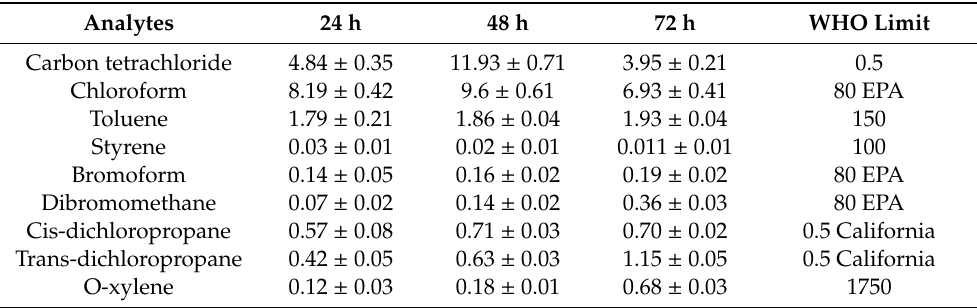
Table 5. Incubation time, total concentration ( µ g / L), and WHO limits of leached VOCs compounds from Polyvinyl chloride (PVC)